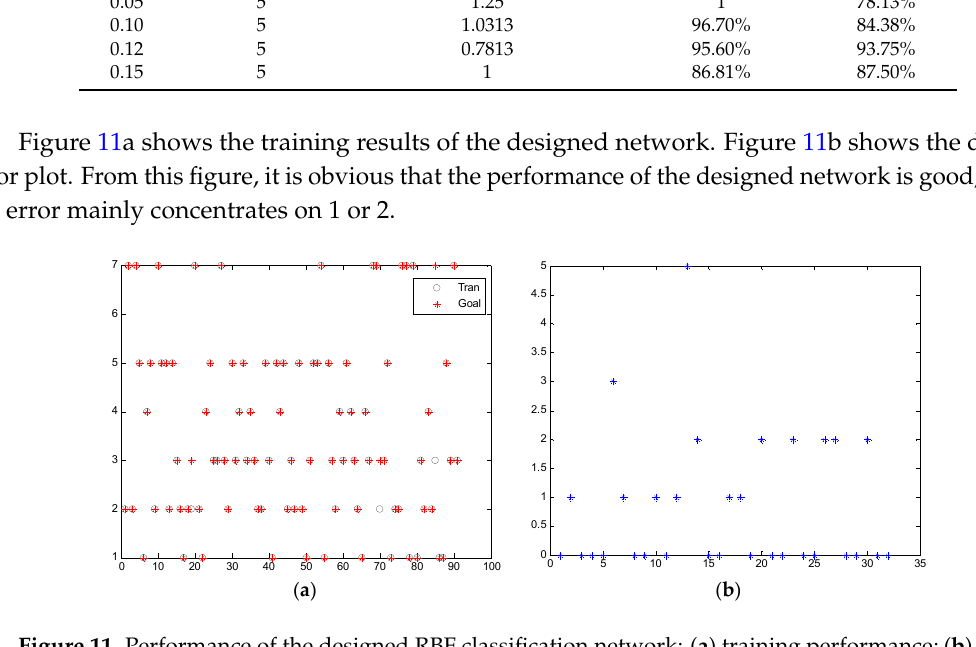
2 wires. Table 2. Performance of the various RBF classification networks when the absolute limiting error was 2 wires.